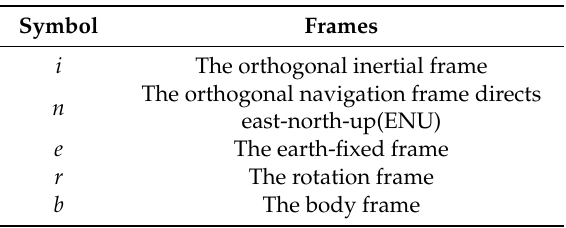
Table 1. The definition of